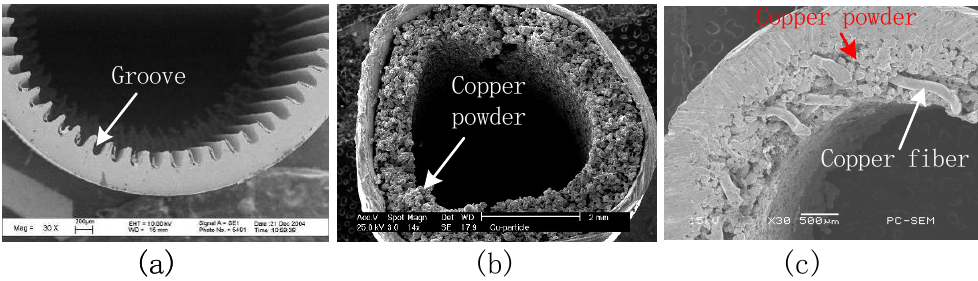
Figure 1. Different wick structures of traditional heat pipes ( a ) groove, ( b ) copper powder sintering and, ( c ) compound types of wick structures.